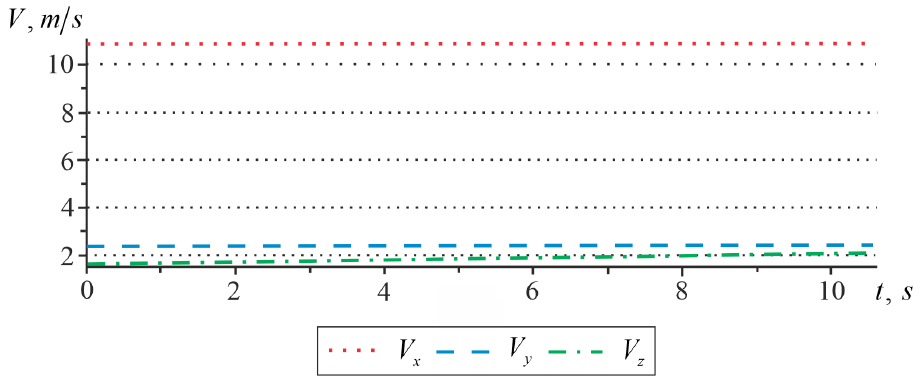
Figure 9. Measured absolute velocities along each of the beams (second simulation).